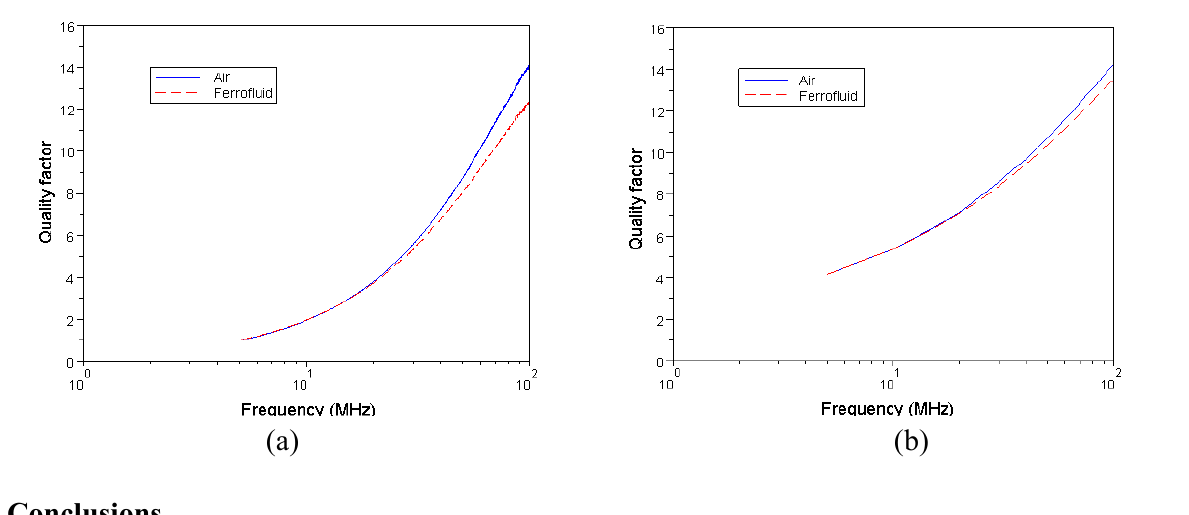
Figure 14. The quality factor of coils with the air core and magnetic core of 1 M Fe nanofluid: (a) measured data; (b) simulated